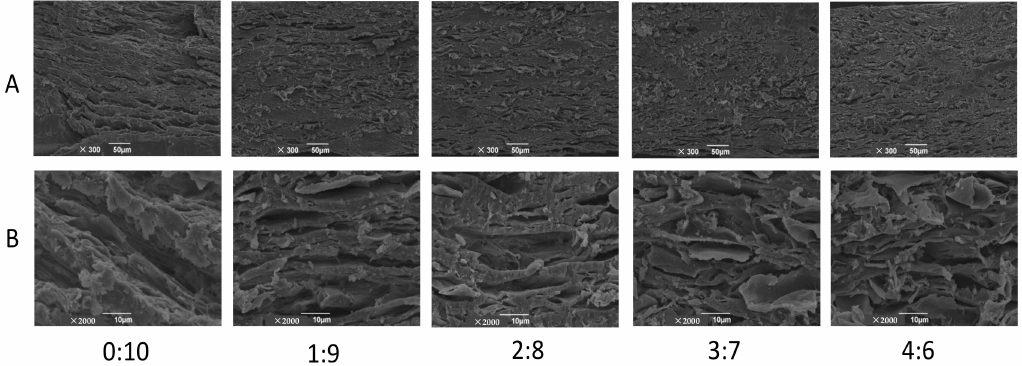
Figure 4. SEM images of extrudates with different surimi to soybean flour ratios (( A )-300 × ; ( B )-2000 ×